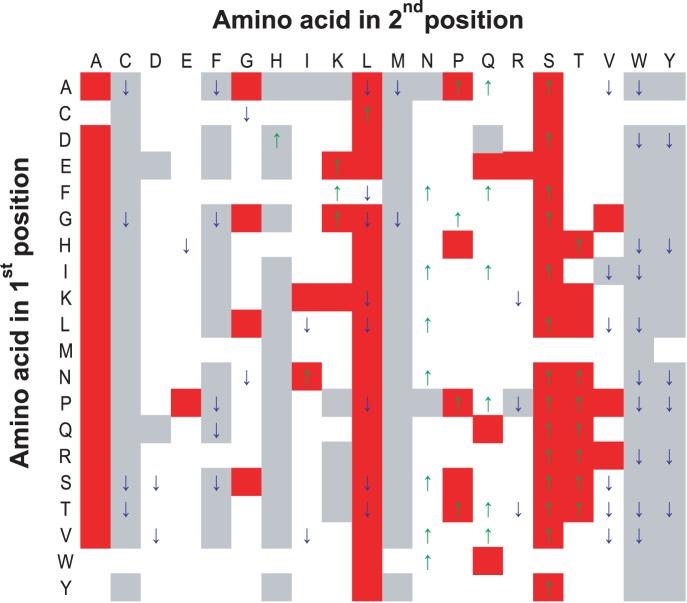
Distribution of bi-amino acids (bi-aa) with significant difference of Aac conditional probability in T3S signal sequences.The vertical and horizontal axis represents the 1st and 2nd amino acid respectively. A binomial distribution-based statistic test was performed to each amino acid at the second position given the first amino acid. The second amino acid with significantly biased composition compared with theoretical random distribution was highlighted in red (enriched) or grey (depleted) background. The second amino acid with significantly biased composition compared with non-T3S sequences was indicated with an upward (higher in T3S sequences) or downward (depleted in T3S sequences) arrow. Benjamini & Hochberg correction for multiple tests was adopted to control the type I errors [30]. The False Discovery Rate (FDR) was set as ≤0.05.